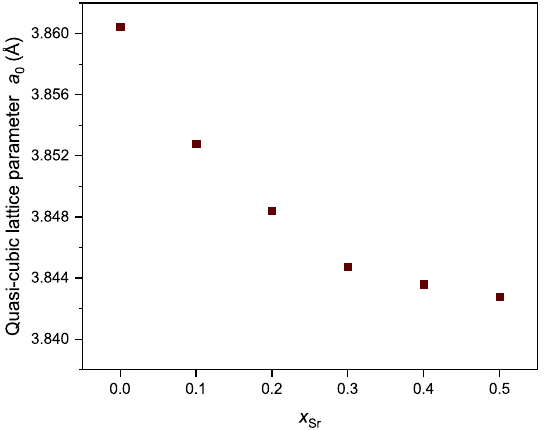
Figure 2. Quasi-cubic lattice parameter of Pr 1– x Sr x (Cr,Mn,Fe,Co,Ni)O 3– δ ( x = 0–0.5) powders after heating at